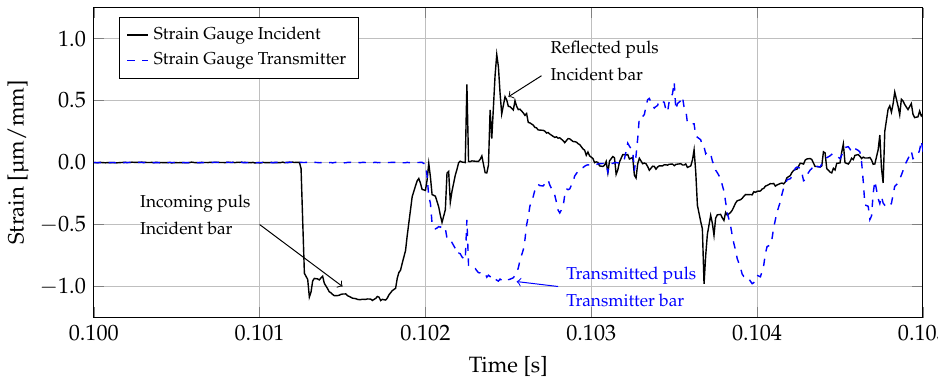
Figure 5. Overview of a typical raw data set from the strain gauges with incoming and reflected pulse in the incident bar (solid black curve) and transmitted pulse in the transmitter bar (dashed blue